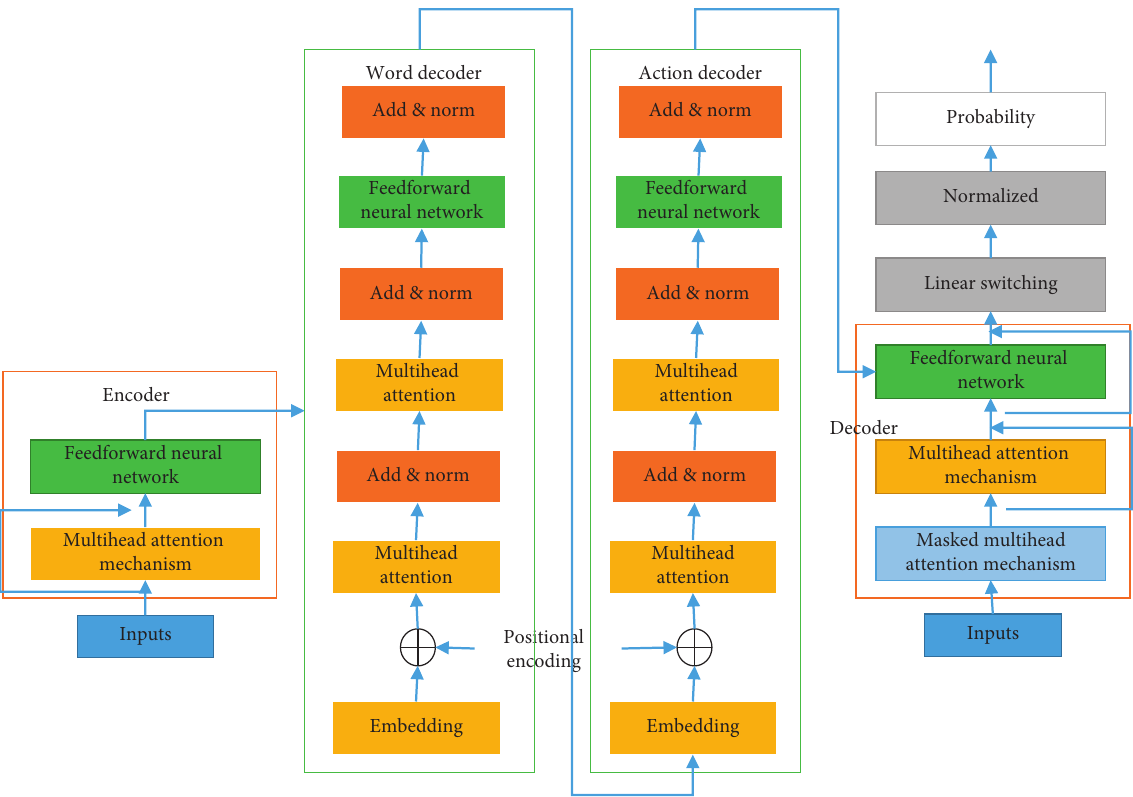
Figure 3: Transformer